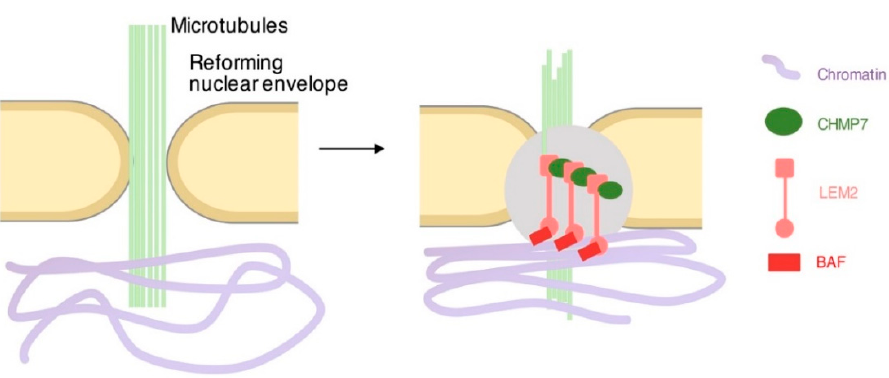
Figure 4. LLPS at the reforming nuclear envelope. During nuclear envelope reformation, membranes are reassembled and nuclear holes surrounding remaining microtubules are sealed by ESCRT machinery. The recruitment of CHMP7 (green) and ESCRT III nucleation is promoted by LLPS of LEM2 (pink) that interacts with BAF (red), which in turn interacts with chromatin (purple) and with CHMP7 through its winged-helix domain.